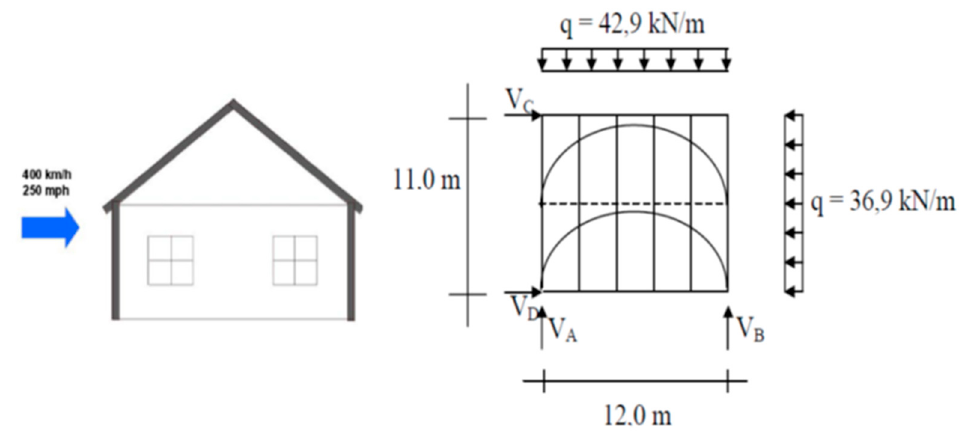
Figure 8. Wind loads based on hurricane conditions [63].